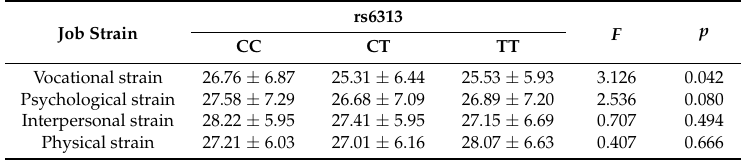
Table 6. Association between rs6313 polymorphism and job strain subscales.